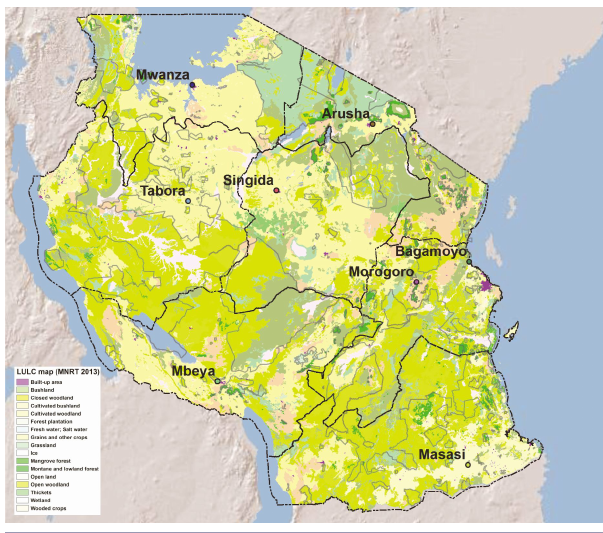
Fig. 2 . Map of Tanzania showing the units of analysis (black lines), which are the management zones for the Tanzania Forest Service, and terrestrial protected areas (grey line) from the World Database on Protected Areas (IUCN and UNEP- WCMC 2015). Points represent the workshop venues for the zones: Singida for Central; Morogoro for Eastern; Mwanza for Lake; Arusha for Northern; Mbeya for Southern Highlands; Masasi for Southern; and Tabora for Western. The national workshop was held in Bagamoyo. The reference land use and land cover map (MNRT 2013) is visible in the background. Shaded Relief: Copyright © ESRI 2014.